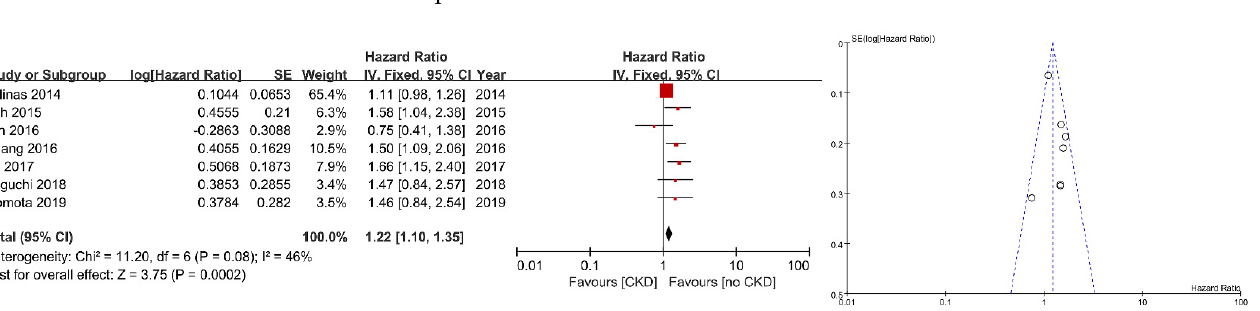
Figure 4. Forest plot and funnel plot of overall survival after radical nephroureterectomy according to preoperative renal function.